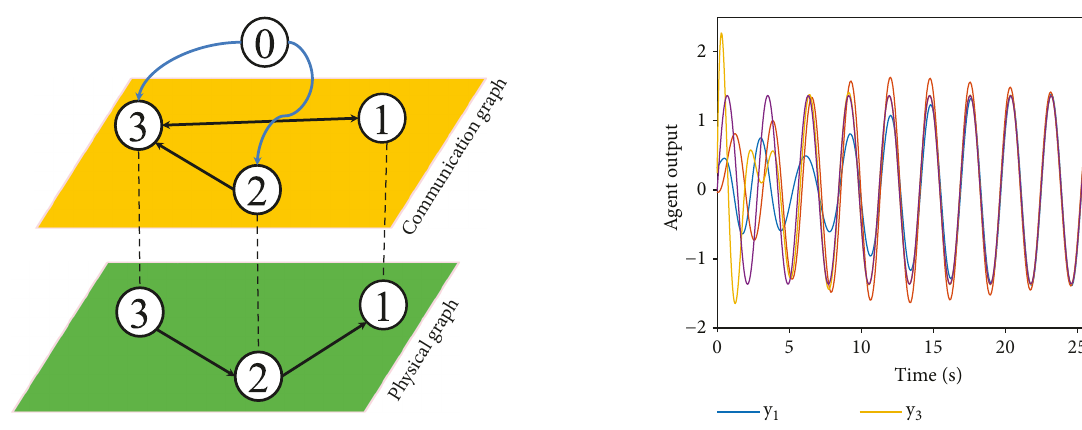
by 0 Figure 5: The tracking error e feedback control